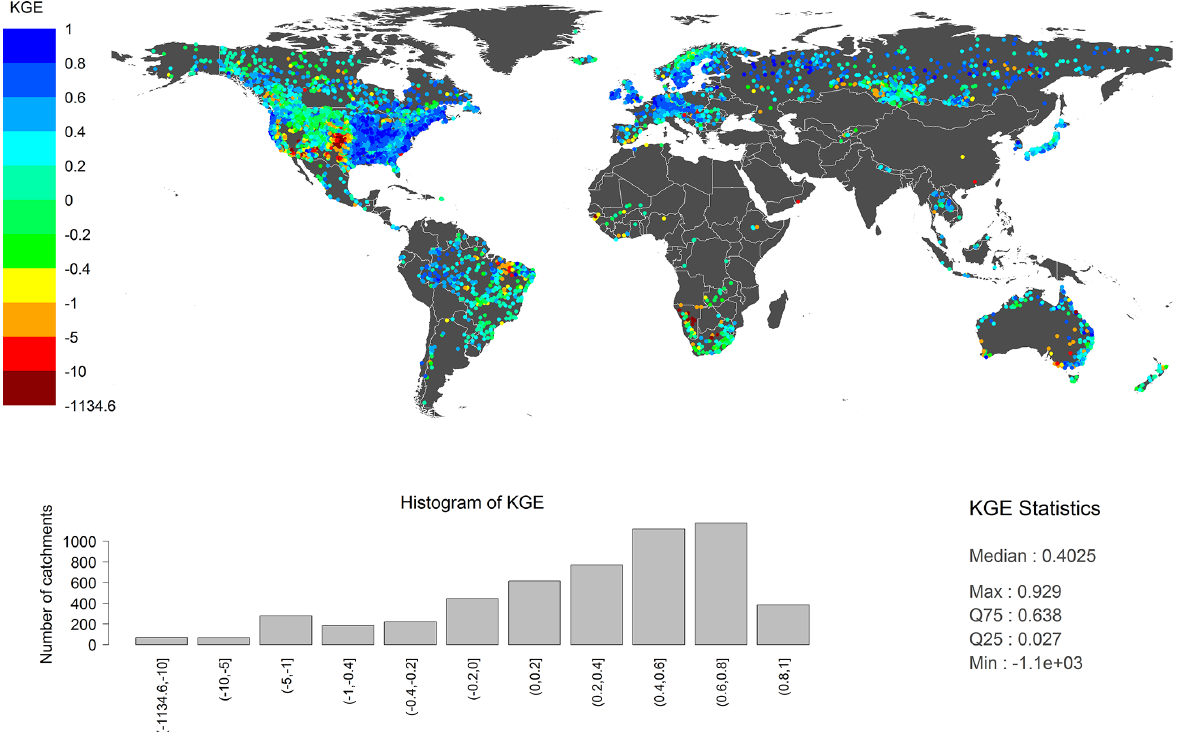
Figure 6. Model performance of WWH version 1.3 using the KGE metric of monthly values of ≥ 10 years in each of the 5338 gauging sites for the period 1981–2012. Blue and green indicate that the model provides more information than the long-term observed mean